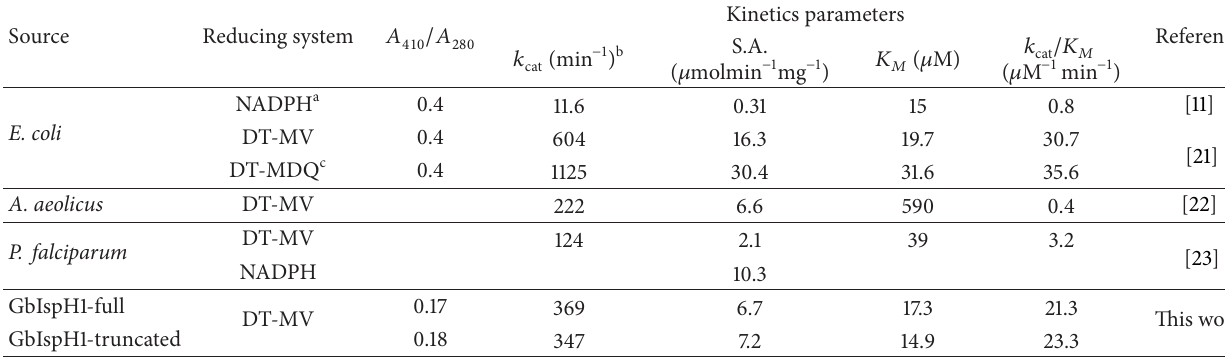
Table 1: Kinetic parameters of IspH proteins.